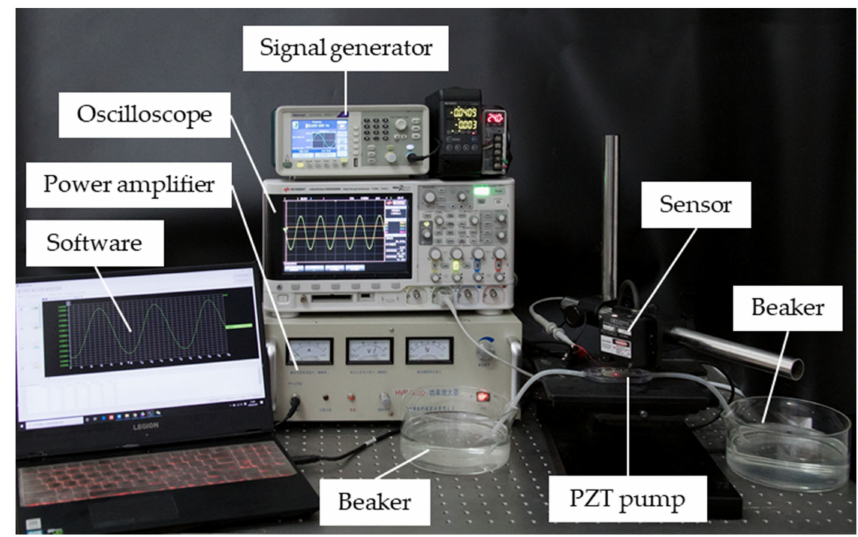
Figure 5. Amplitude detection